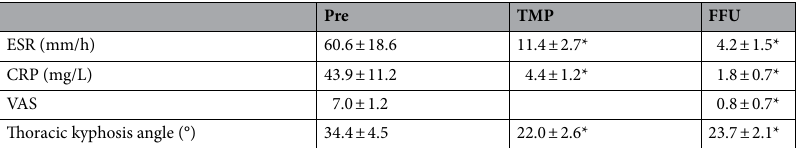
Table 2. Clinical evaluation indices of the preoperative and postoperative follow-up (average ± standard deviation). *Analyzed by paired t test, compared with preoperatively, p < 0.05. Pre preoperative, Post postoperative, TMP 3 months postoperative, FFU final follow-up.